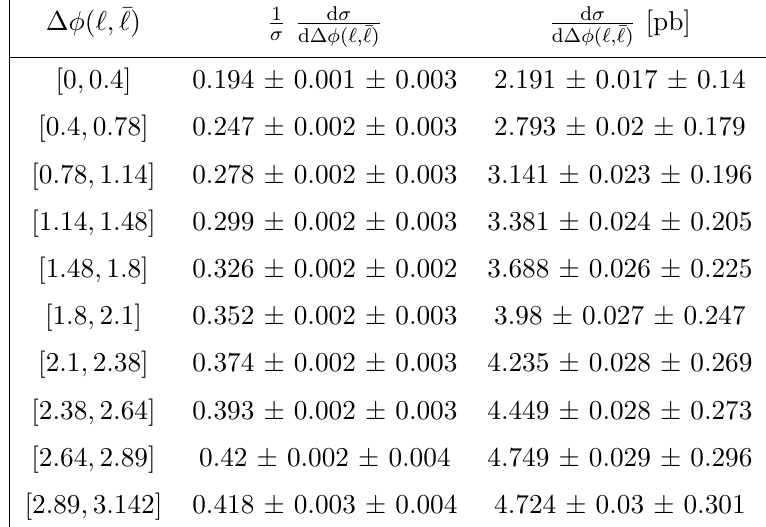
Table 39 . The measured di(cid:11)erential cross section and bin boundaries for each bin of the normalized and absolute measurements of the tt di(cid:11)erential cross section at particle level in the (cid:12)ducial phase space as a function of (cid:1) (cid:30) ( ‘; (cid:22) ‘ ) are tabulated.